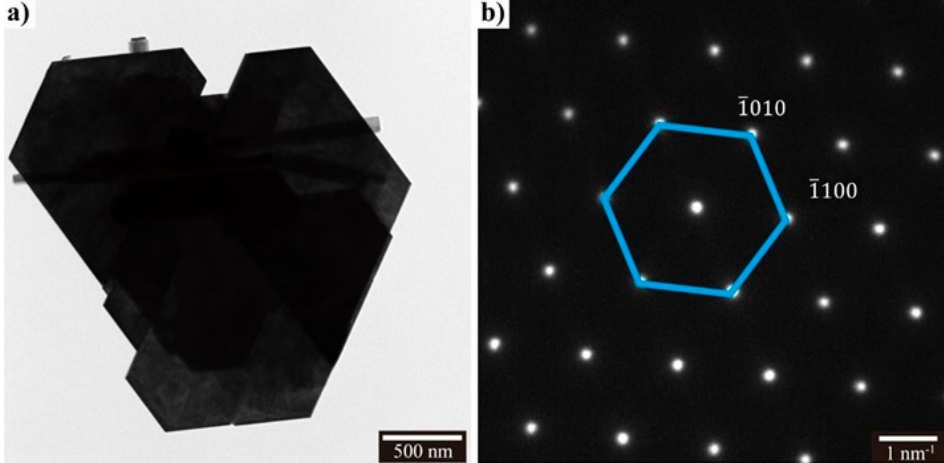
Figure 2. TEM micrograph of the 𝑊𝐶𝑙 (cid:2874) h- 𝑊𝑂 (cid:2871) ( a ) and SAED pattern ( b